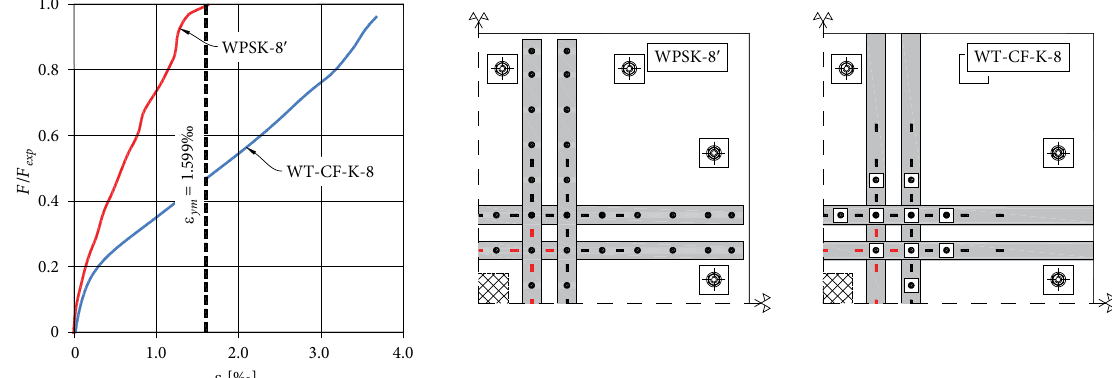
Figure 8. Comparison between strains of the external reinforcement of the specimens WT-CF-K-8 and WPSK-8 ′ according to the load level F / F exp , Urban et al. (2010)